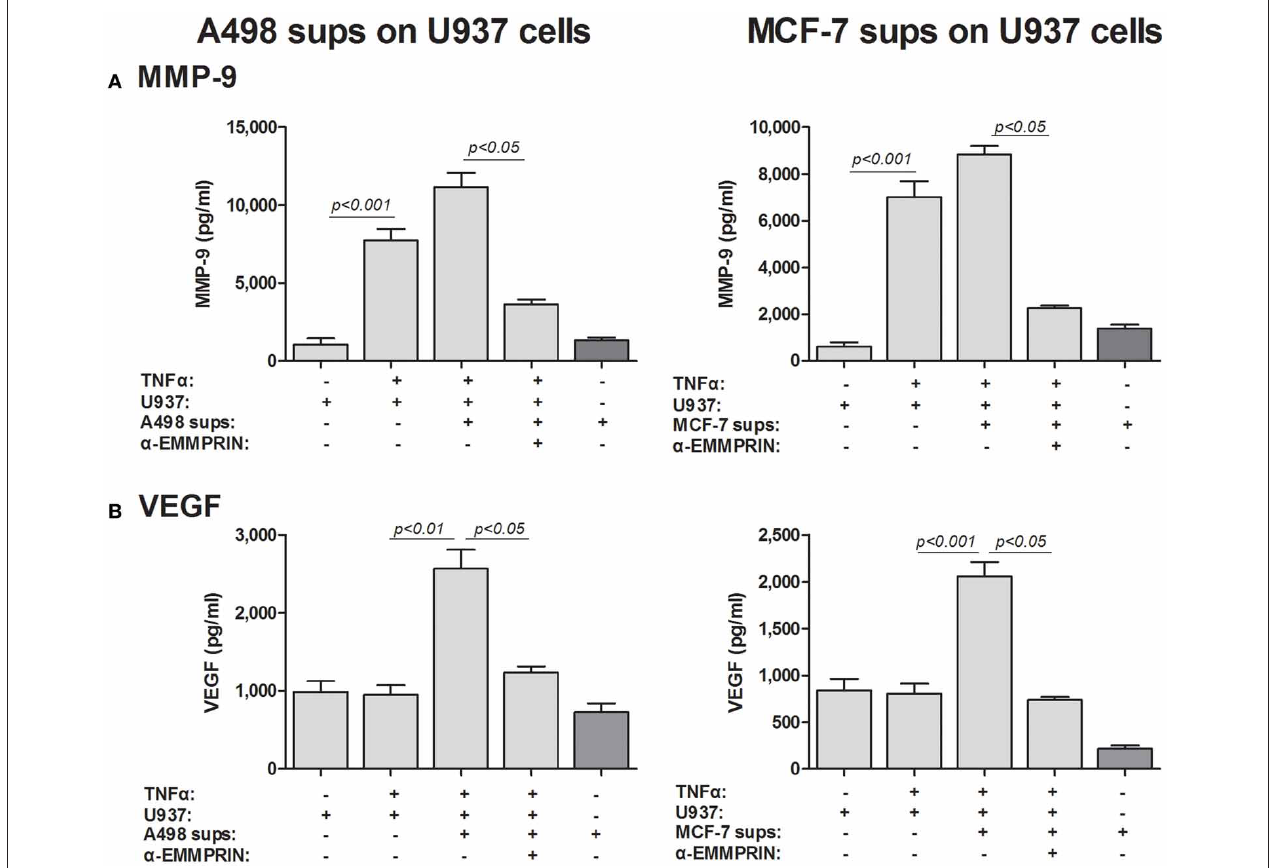
FIGURE 7 | Effect of cancer cell supernatants on monocyte expression of VEGF and MMP-9 is mediated through soluble EMMPRIN. 2 × 10 5 U937 cells were separately incubated in the presence of TNF α (1ng/ml) for 48h